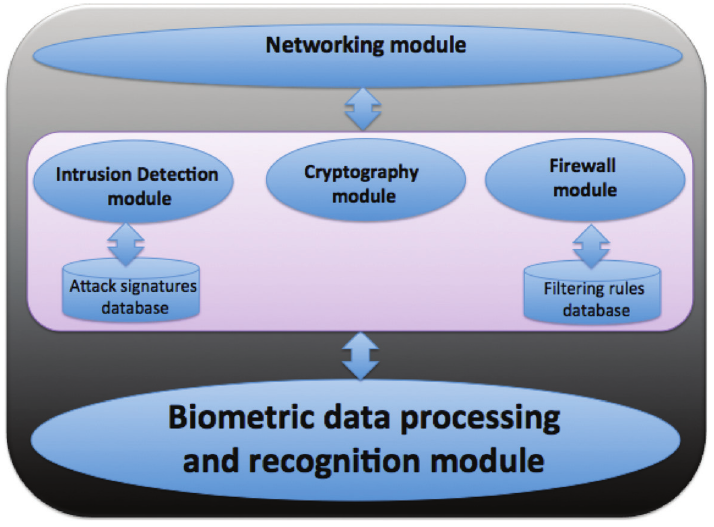
Figure 16. Typical Secure Biometric Reader